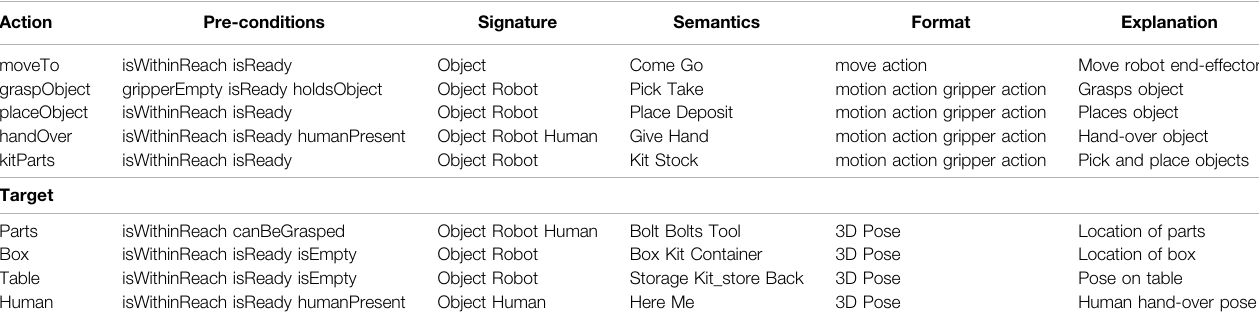
TABLE 1 | Coordination of shared tasks is commanded by < action,target > -pairs that specify an action to be executed by the robot, with an accompanying target. Speci fi c details of the architecture are as follows: Pre-conditions-checks whether certain conditions of the world and its content prior to execution are met (e.g., object location, state/capabilities oftherobot). Signature-speci fi esonto whichthe action/target acts; object, robot and/or human. Semantics-lists the differentcommands thatcan be used for triggering the same action/target. Format-describes the underlying knowledge format. Explanation-provides details of the action/target and its speci fi c (sub)